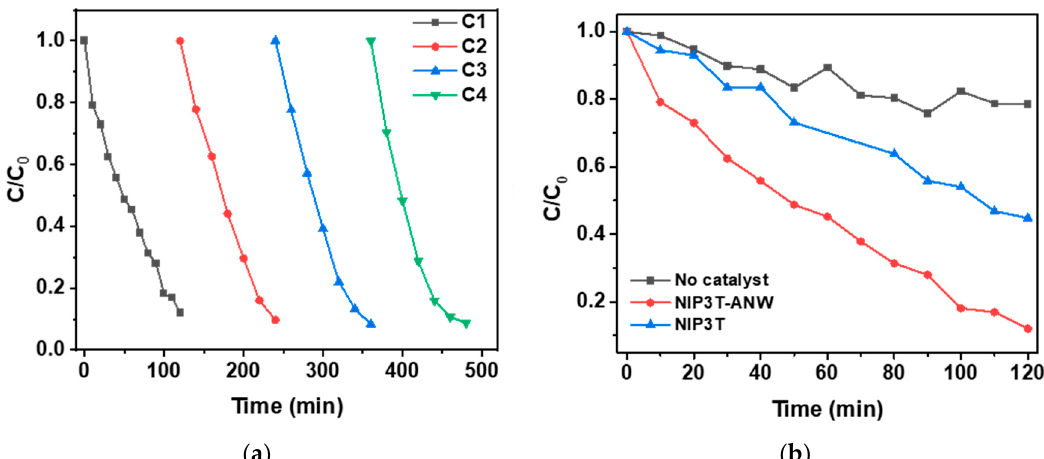
Figure 19. RhB degradation curves. ( a ) Comparison among NIP3T , NIP3T-ANW and without catalyst in the degradation performance. ( b ) Stability of NIP3T-ANW after four recycling cycles. Reproduced from M. J. Alonso-Navarro, J. Barrio, S. Royuela, N. Karjule, M. M. Ramos, J. I. Martínez, M. Shalom and J. L. Segura, RSC Adv. 2021, 11 , 2701—Published by The Royal Society of Chemistry [41].